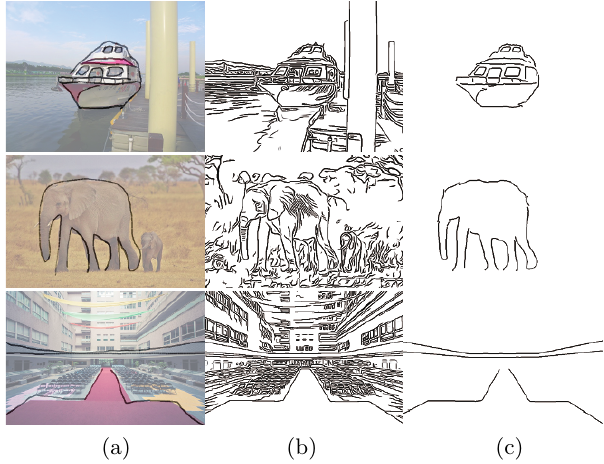
Fig. 5 Coherence line matching results. (a) Input images and user specified coherence strokes. (b) Detailed line drawings using fDoG [2]. (c) Lines extracted by coherence line matching.